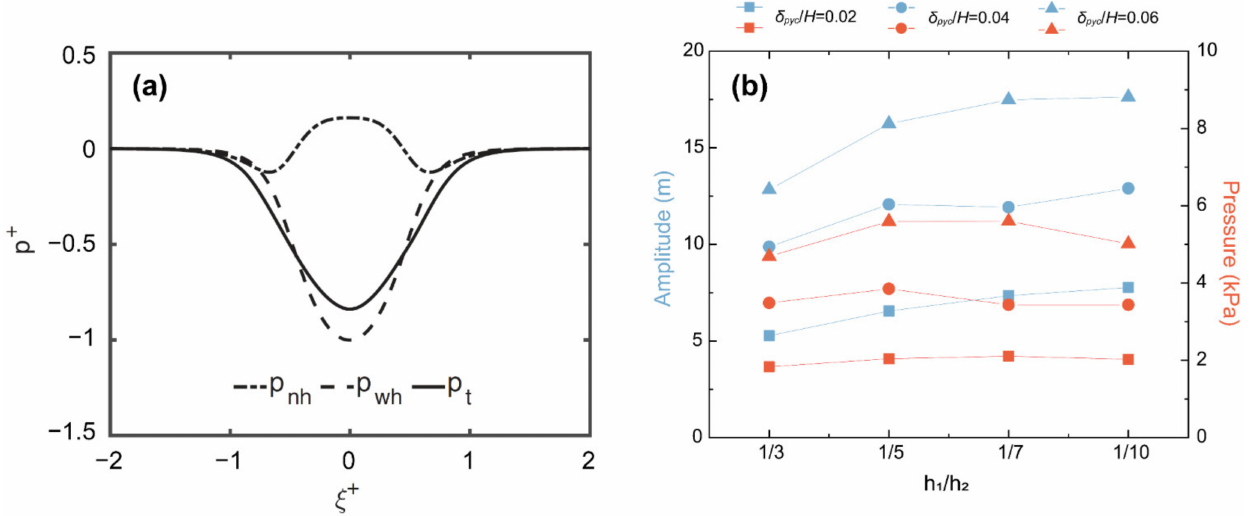
Figure 4. Bottom pressure induced by internal solitary waves for different environmental parameter schemes. ( a ) ISW-induced bottom pressure with a thickness ratio of h 1 / h 2 = 1/7. The dash–dash line, dash–dot line, and solid line show the hydrostatic pressure, the non-hydrostatic pressure, and the summation of the above, respectively. ( b ) Amplitude and pressure changes of ISWs for the different ratios of pycnocline thickness δ pyc and the ratio of upper and lower water depths. Panel ( a ) adapted from Rivera-Rosario et al. [21], with permission from Wiley. And the data of panel ( b ) come from Table 2 of Rivera-Rosario et al. [21].